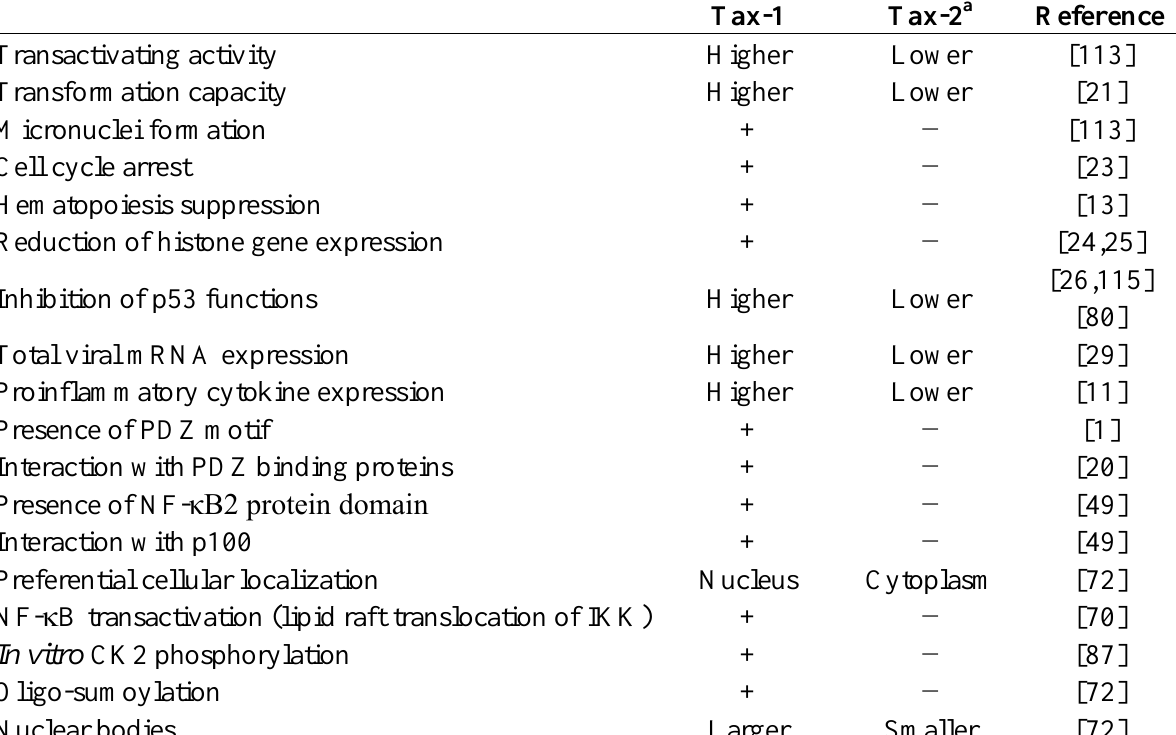
Table 2. Summary of main functional and structural differences between Tax-1 and